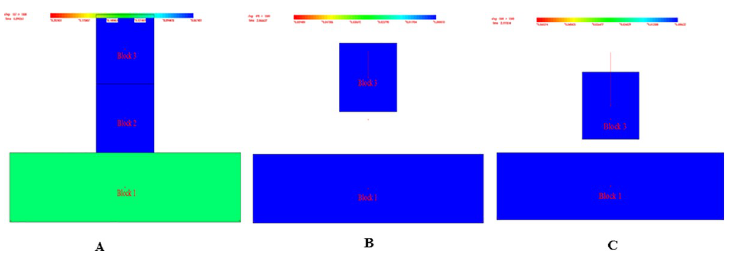
Fig 9. Block calculation process diagram. (A) time step 157, time 0. 89s. (B) time step 498, time 2.06s. (C) time step 1500, time 2.19s.